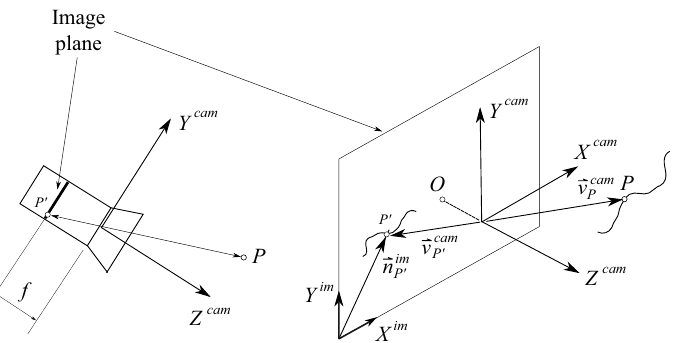
Figure 4. Kinematics of the computer vision.